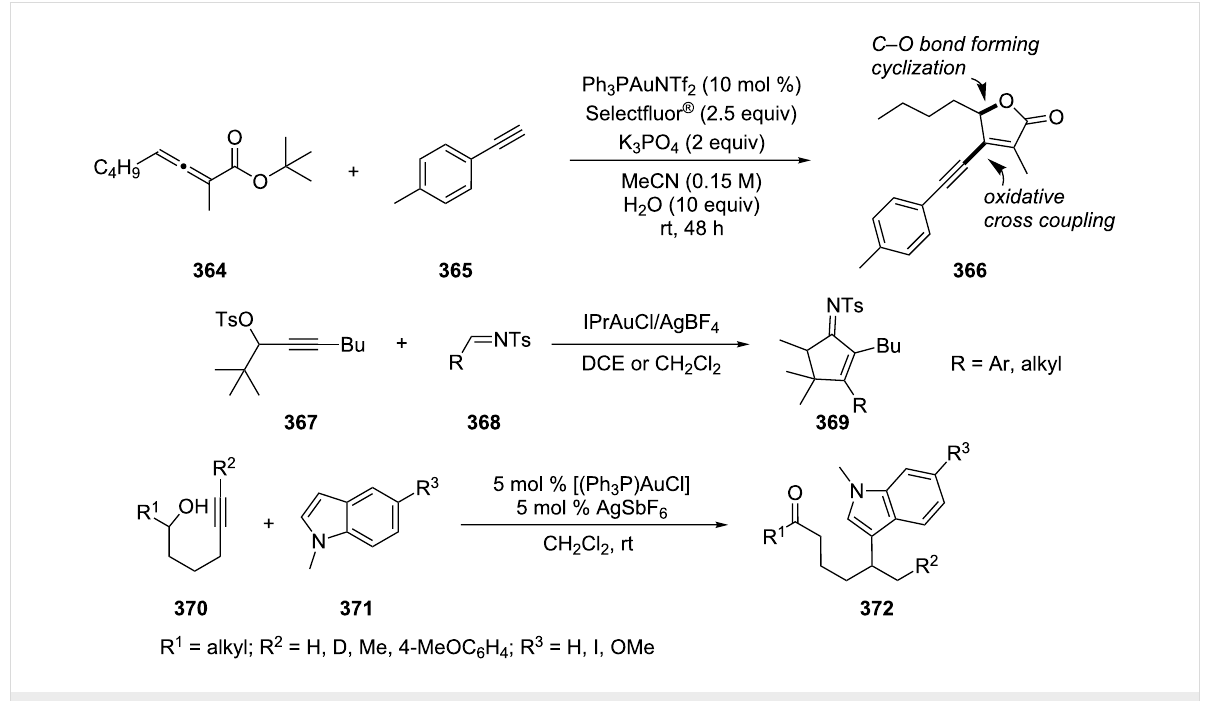
Scheme 59: Gold-catalyzed tandem reactions of allenoates and alkynes.